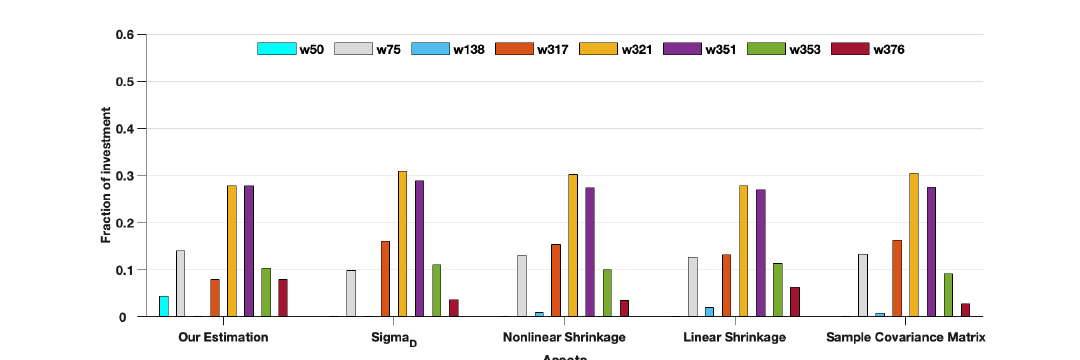
Figure 7. The assets’ weights of each estimation under the out-of-sample data N = 200.